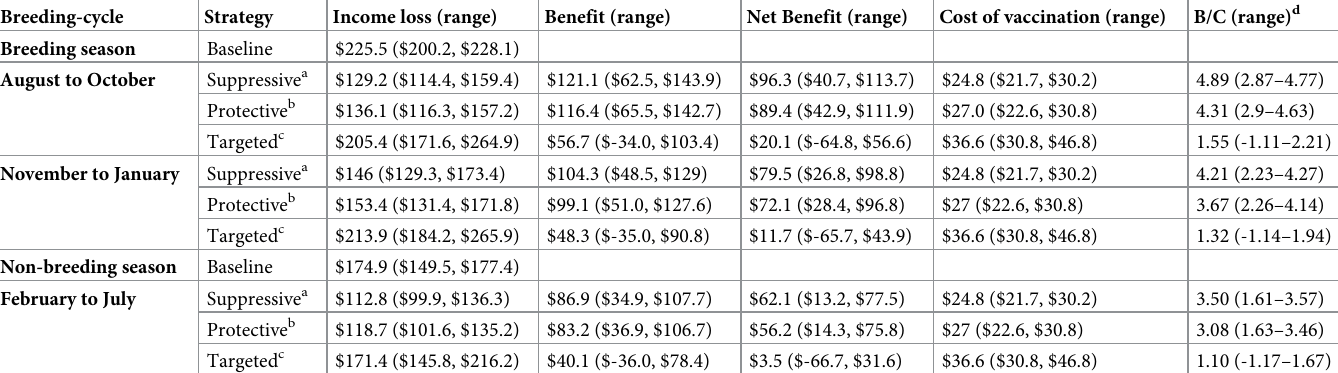
Table 4. The estimated cost of vaccination, and losses prevented (benefits) for the nine alternative control scenarios, compared to baseline strategies applied in either the breeding season (August to January) or non-breeding season (February to July). The duration of the outbreak, number of infected and vaccinated properties determined through simulation